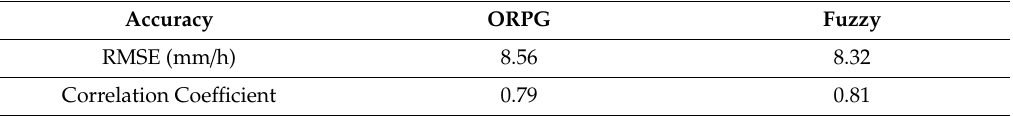
Table 2. Comparison of the accuracy of radar-based precipitation estimates in each quality control algorithm and bias correction method.